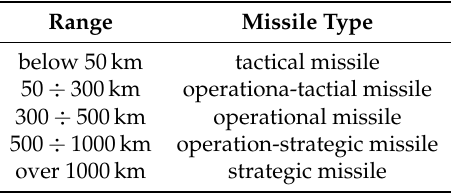
Table 4. Missile types